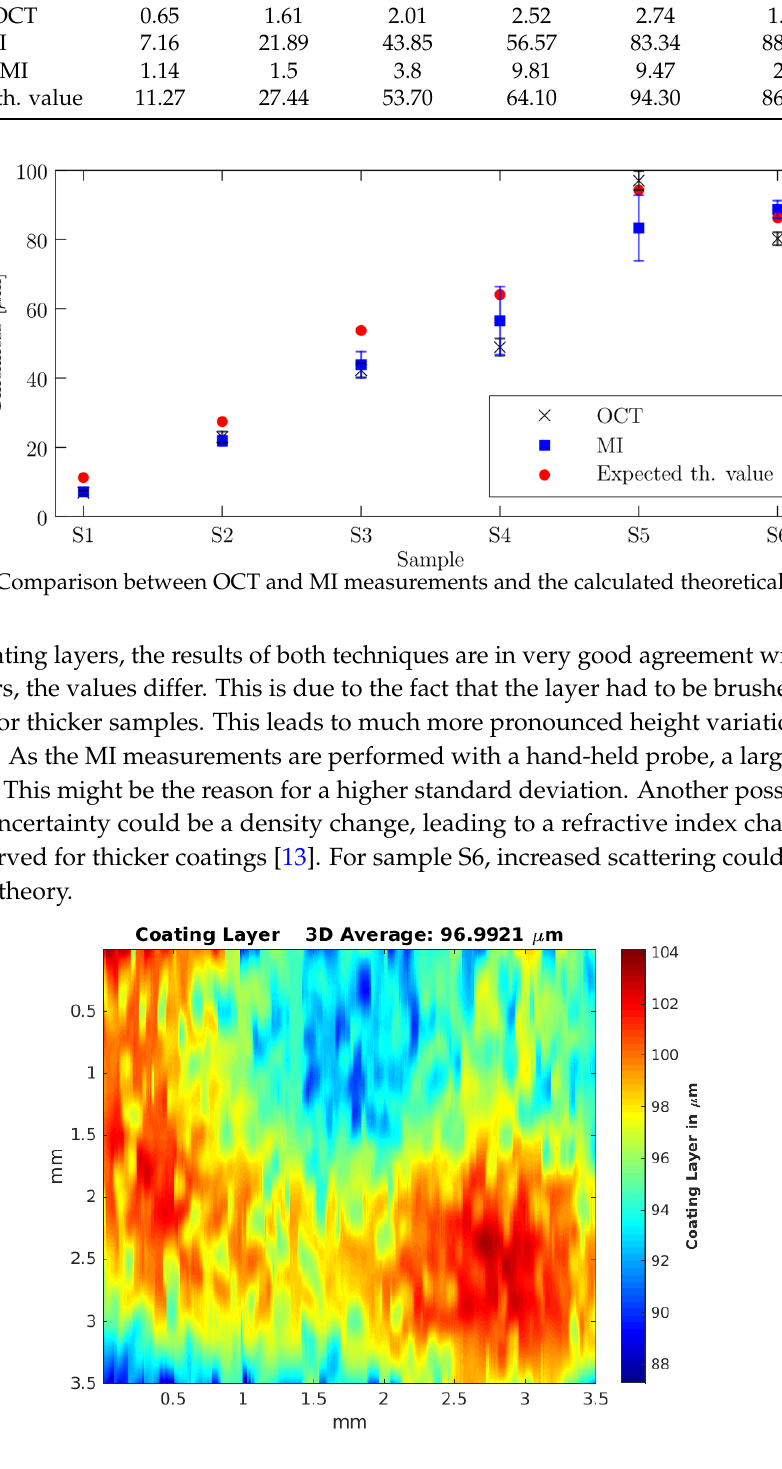
Figure 5. 3D heat map of the calculated layer thickness for the OCT measurement of sample